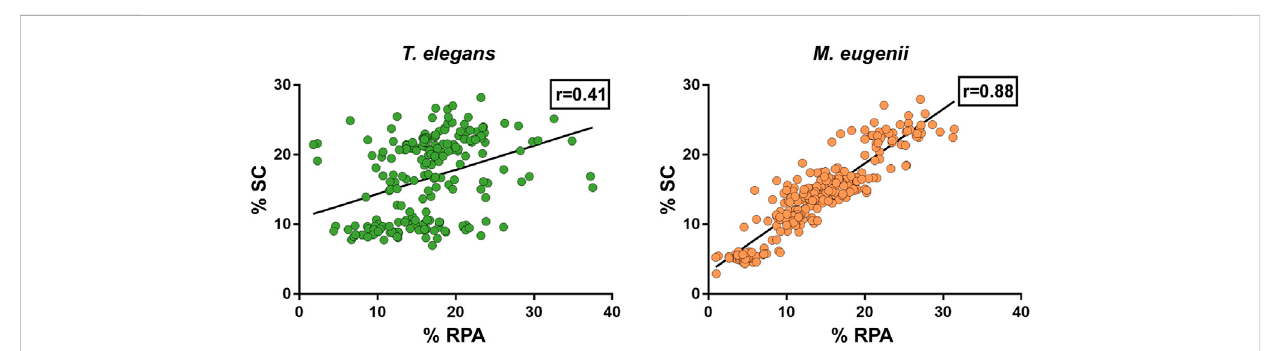
FIGURE 9 Compared proportion of RPA foci number and SC length chromosome in Thylamys elegans and Macropus eugenii . Each spot represents a bivalent in a cell. Black lines represent the calculated regression line. r = Spearman correlation coef fi